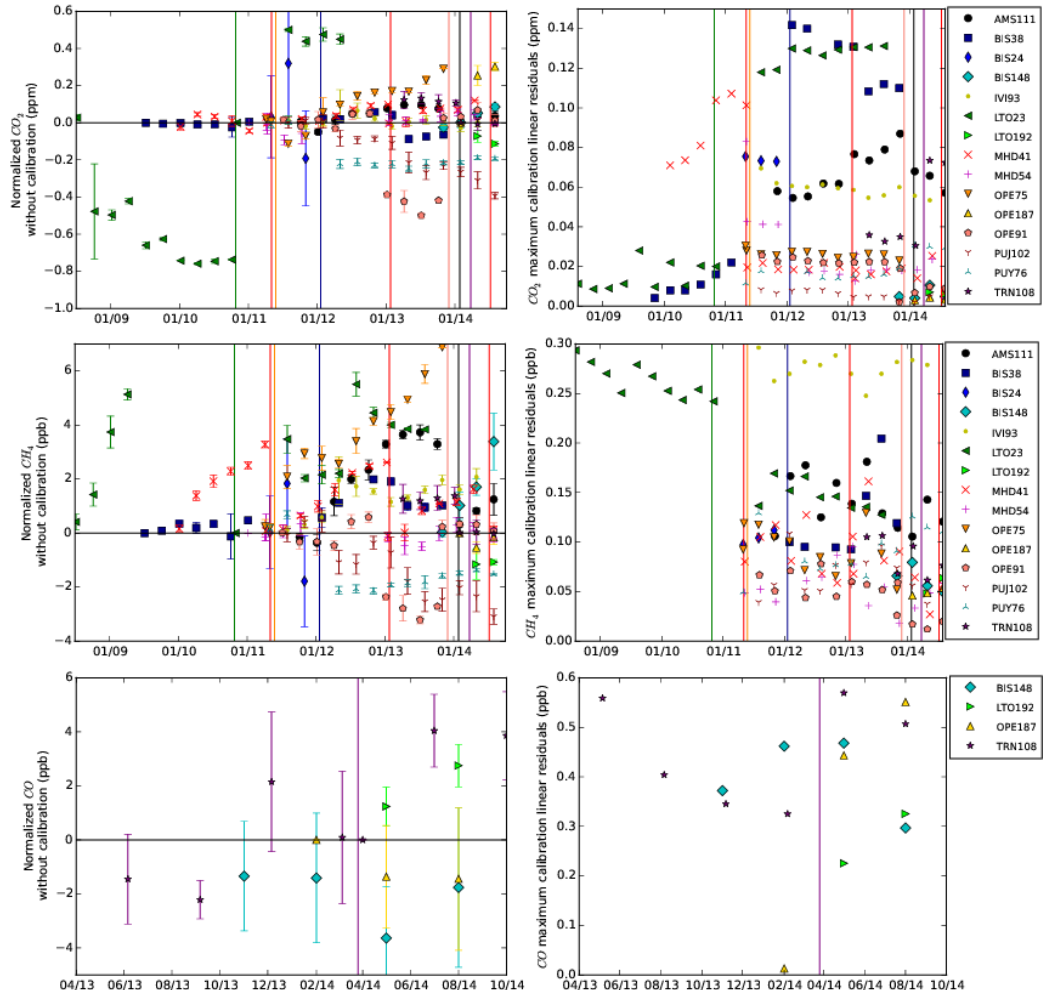
Figure 12. Top: CO 2 . Middle: CH 4 . Bottom: CO. Left: temporal drift of the instrument calculated using a virtual tank with a fixed value after calibration and the calibration equations – the concentrations are normalized using the first calibration. Right: temporal evolution of the residuals from the calibration linear fit. The vertical solid lines show a change of calibration scales. For all the panels, each data point is a 3-month